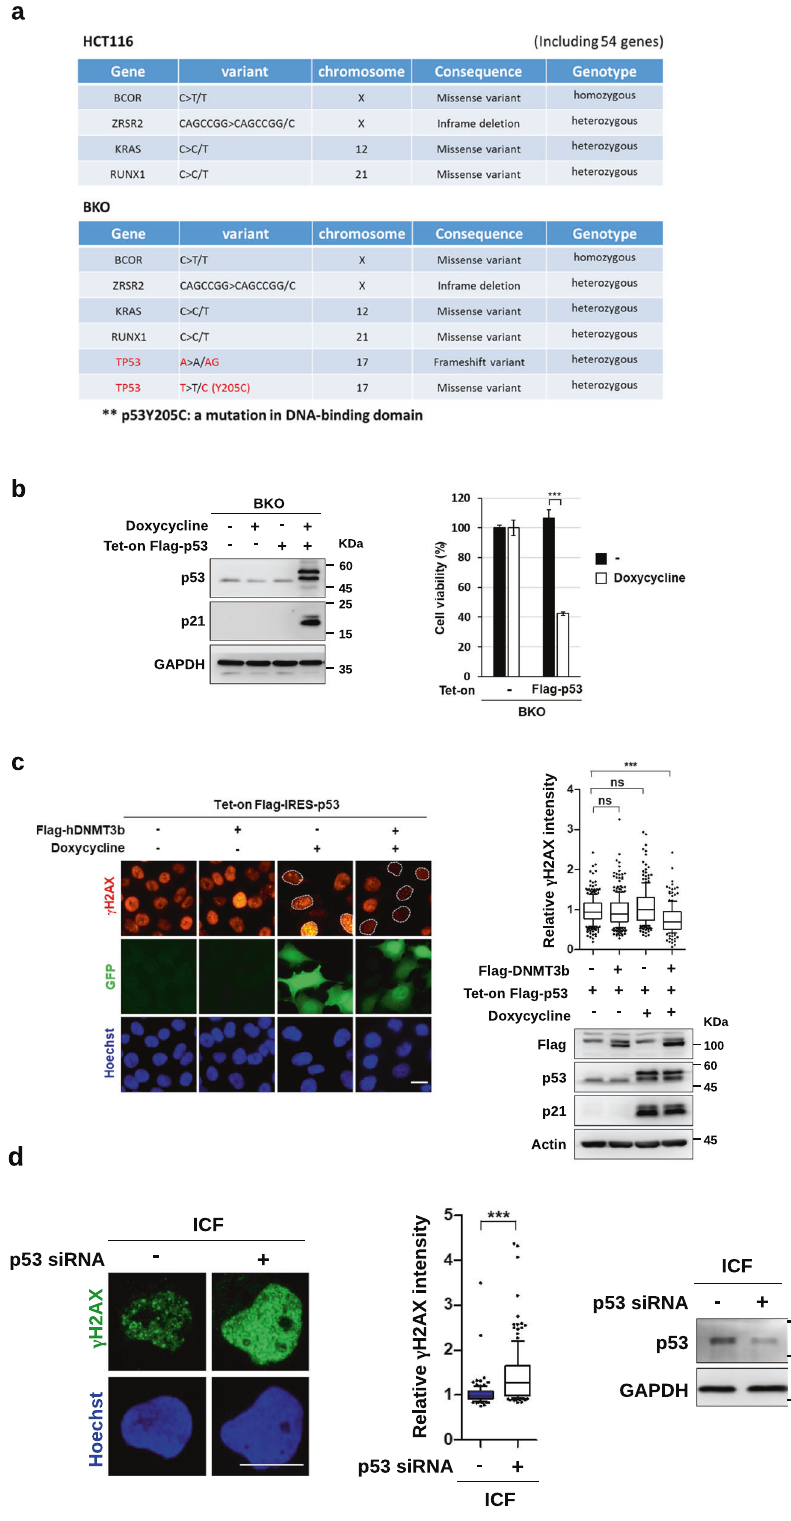
Unexpectedly, the analyses revealed that the steady-state levels of (peri-)centromeric R-loop in HCT116 was indeed higher than those in BKO cells (Fig. 5a). DRIP analysis showed that XPG/XPF depletion brought up the level of centromeric R-loop in BKO but not WT HCT116 cells (Fig. 5b). Thus, in BKO cells, (peri-) Cell Death and Disease (2022)